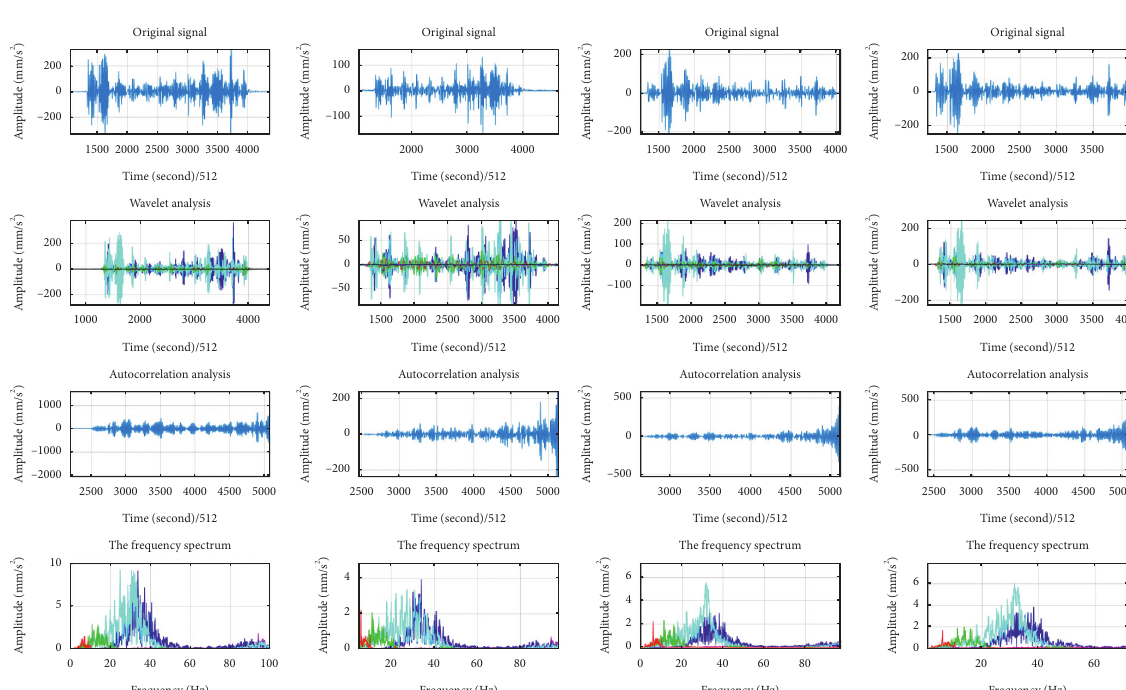
Figure 12: Actual vehicle model running on bridge in case